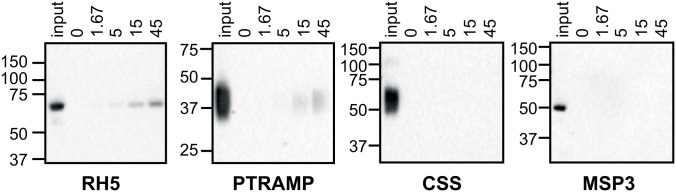
Erythrocyte binding assay demonstrating the ability of PTRAMP but not CSS to bind to receptors on the erythrocyte surface.Increasing amounts of recombinant proteins (in μg) were incubated with human erythrocytes, before repeated separation steps through oil and elution of bound protein. Immunoblots of eluted proteins are shown, probed with anti-His antibody. Recombinant RH5 and MSP3 were used as positive and negative controls respectively. Molecular mass standards are indicated on the left of each panel (in kDa).